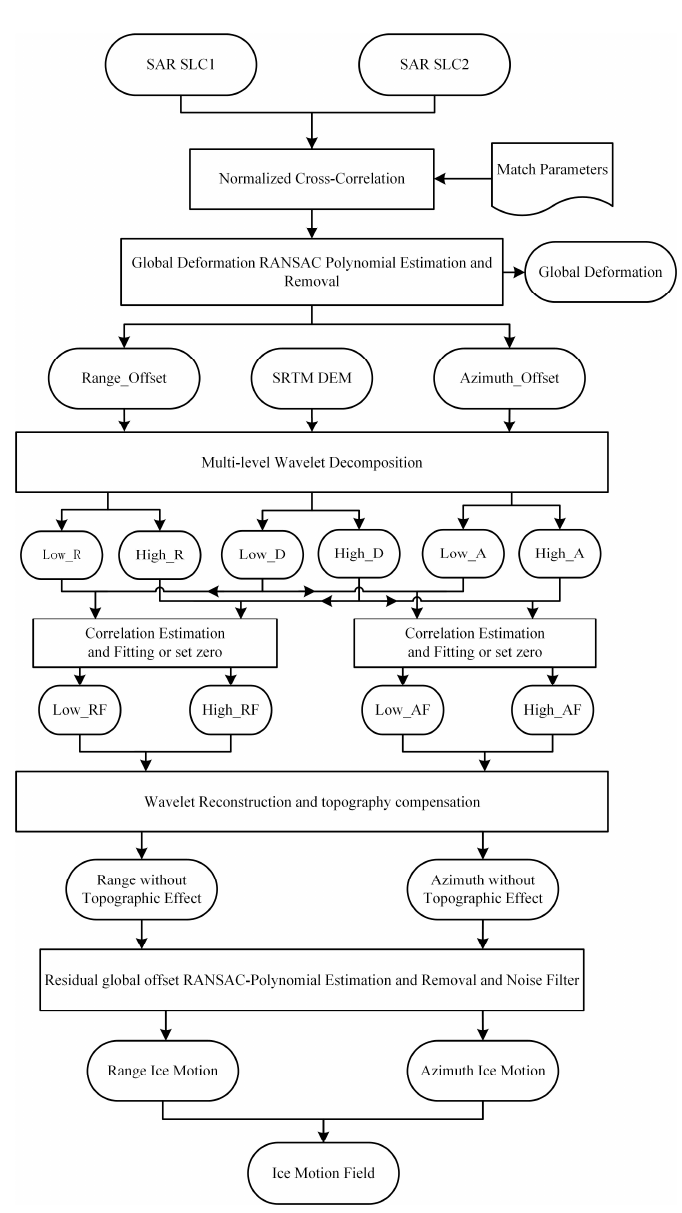
Figure 2. Data-processing flowchart. “Low” and “high” correspond to the low-frequency and high-frequency parts of the signal in the wavelet domain, respectively. R, A, and D mean the ice motion in the range direction, the azimuth direction, and the digital elevation model (DEM). F means the corresponding fitting results.